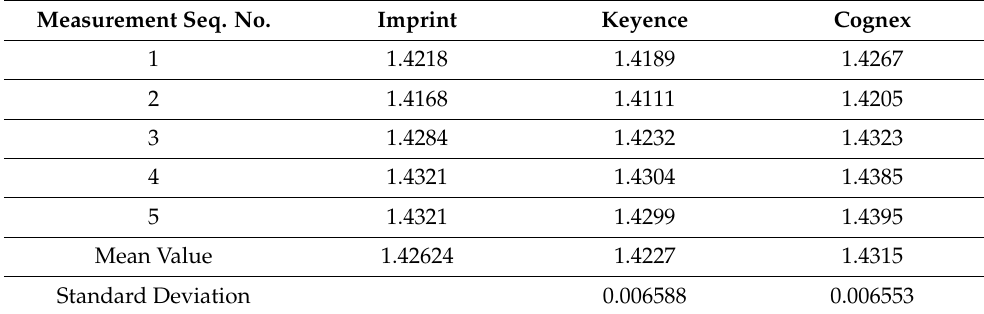
Table 2. Fillet radius R02 measurement.